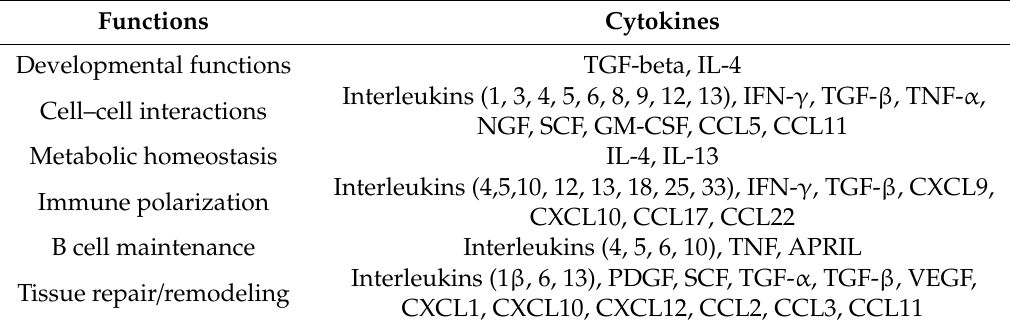
Table 1. E ff ects of cytokines produced by eosinophils [120].